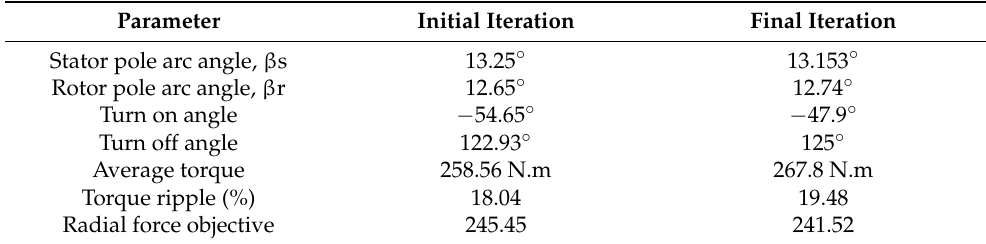
Figure 6. Block diagram of the dynamic optimization stage [23]. Table 2. The improvements of the motor performance after five iterations in the dynamic design process for the selected